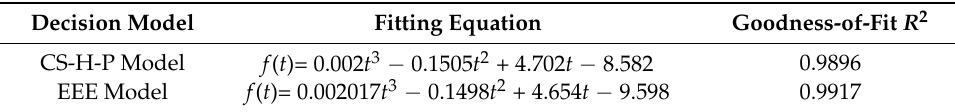
Table A2. Fitting equation of carbon dioxide absorption with time.